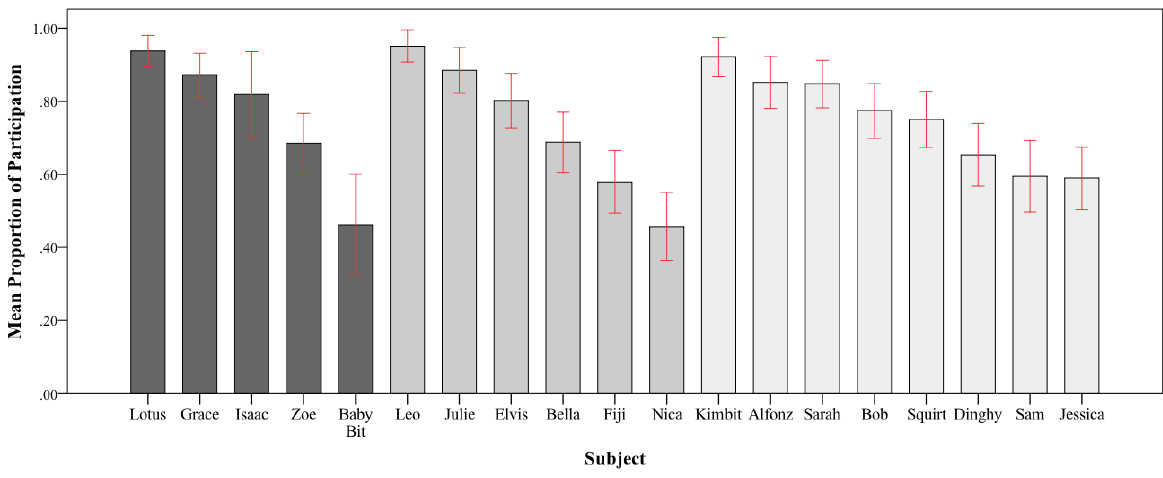
Figure 6. Mean (±2 SE) proportion of participation for each subject, including all trials and all enrichment classes. Age class is delineated by color: calves = dark grey, sub-adults = medium grey, and adults = light